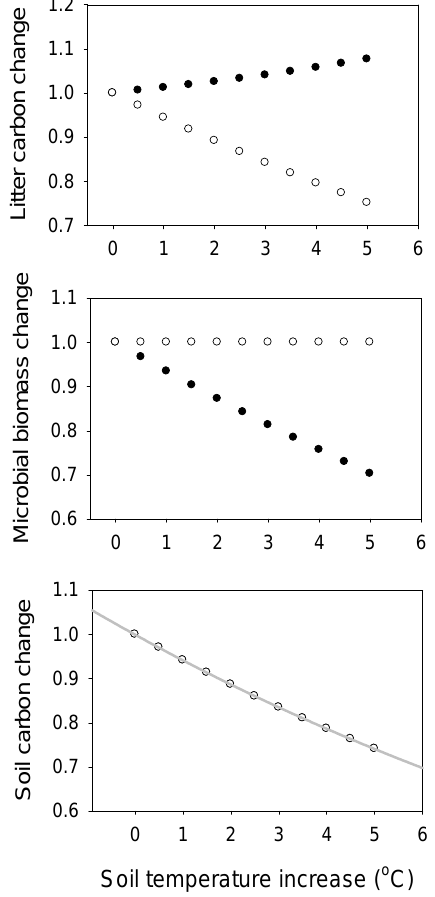
Fig. 8. Normalized equilibrium responses of the litter carbon, mi- crobial biomass or soil carbon to soil warming by the three-pool model with α = 0. The open and black solid circles represent the change in pool size with temperature-independent microbial growth efficiency (0.39) or temperature-dependent microbial growth effi- ciency (a change from 0.39 at 15 ◦ C to 0.31 at 20 ◦ C), respectively. Response of soil carbon to warming is independent of ε and can be explained by a Q 10 function ( C s (1T s ) = Q ( 0 . 1 1T s ) , where 1T s is the soil warming in ◦ C) with Q 10 of 1.8. Change in each pool size is calculated as change relative to the equilibrium pool size at T s = 15 ◦ C.